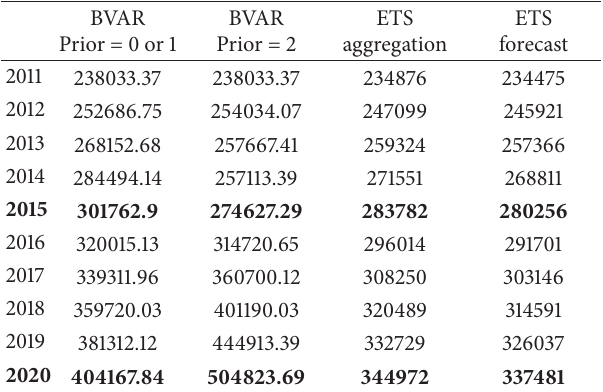
Table 5: Total coal consumption